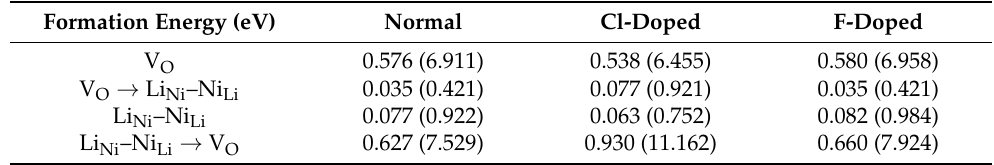
Table 3. Typical defect formation energy of full lithium